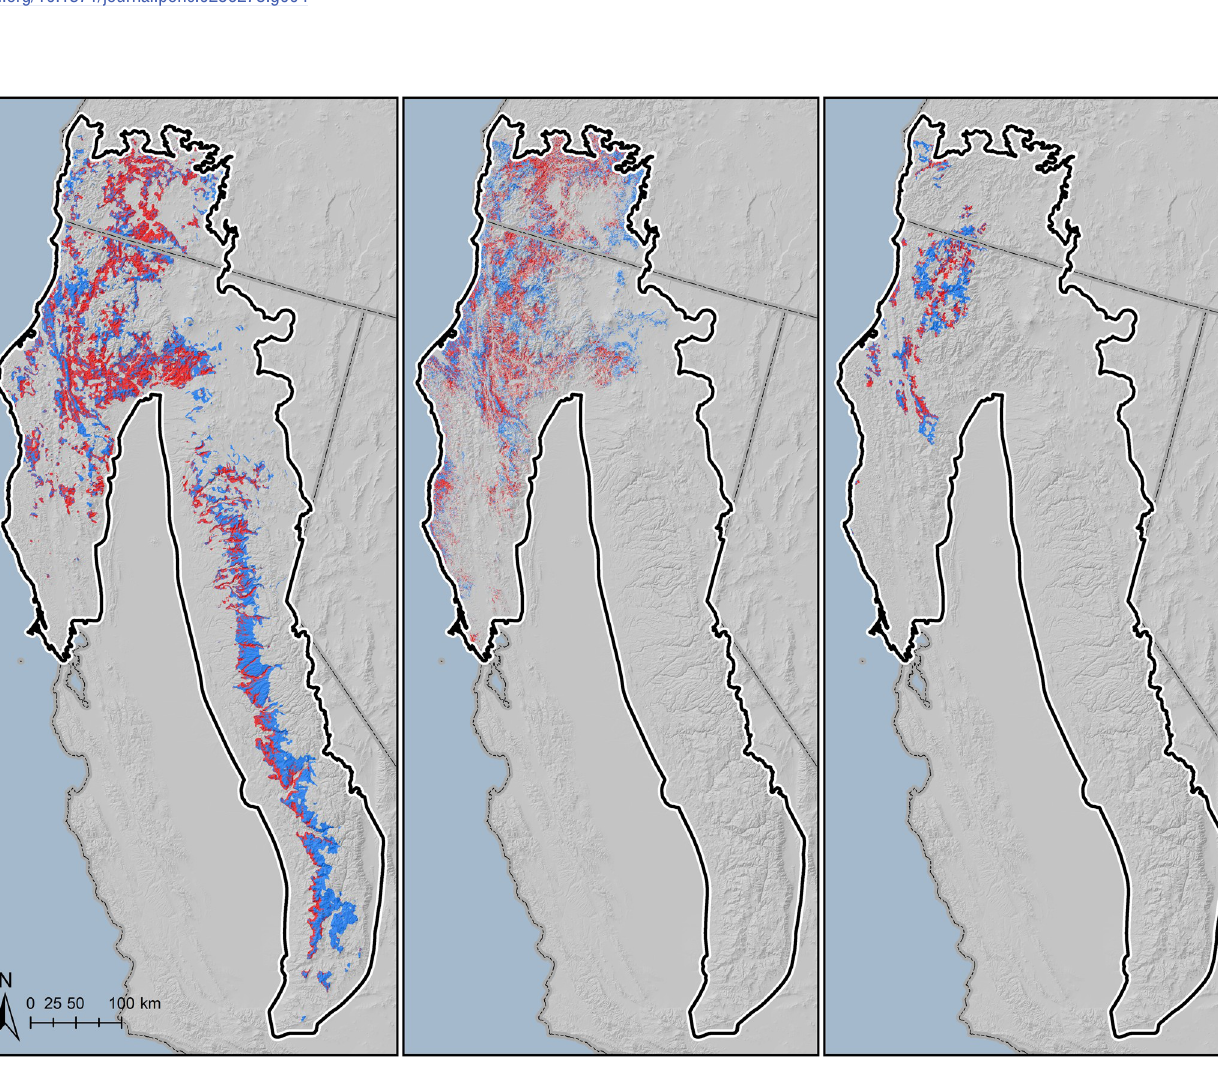
PLOS ONE | https://doi.org/10.1371/journal.pone.0256273 September 1,